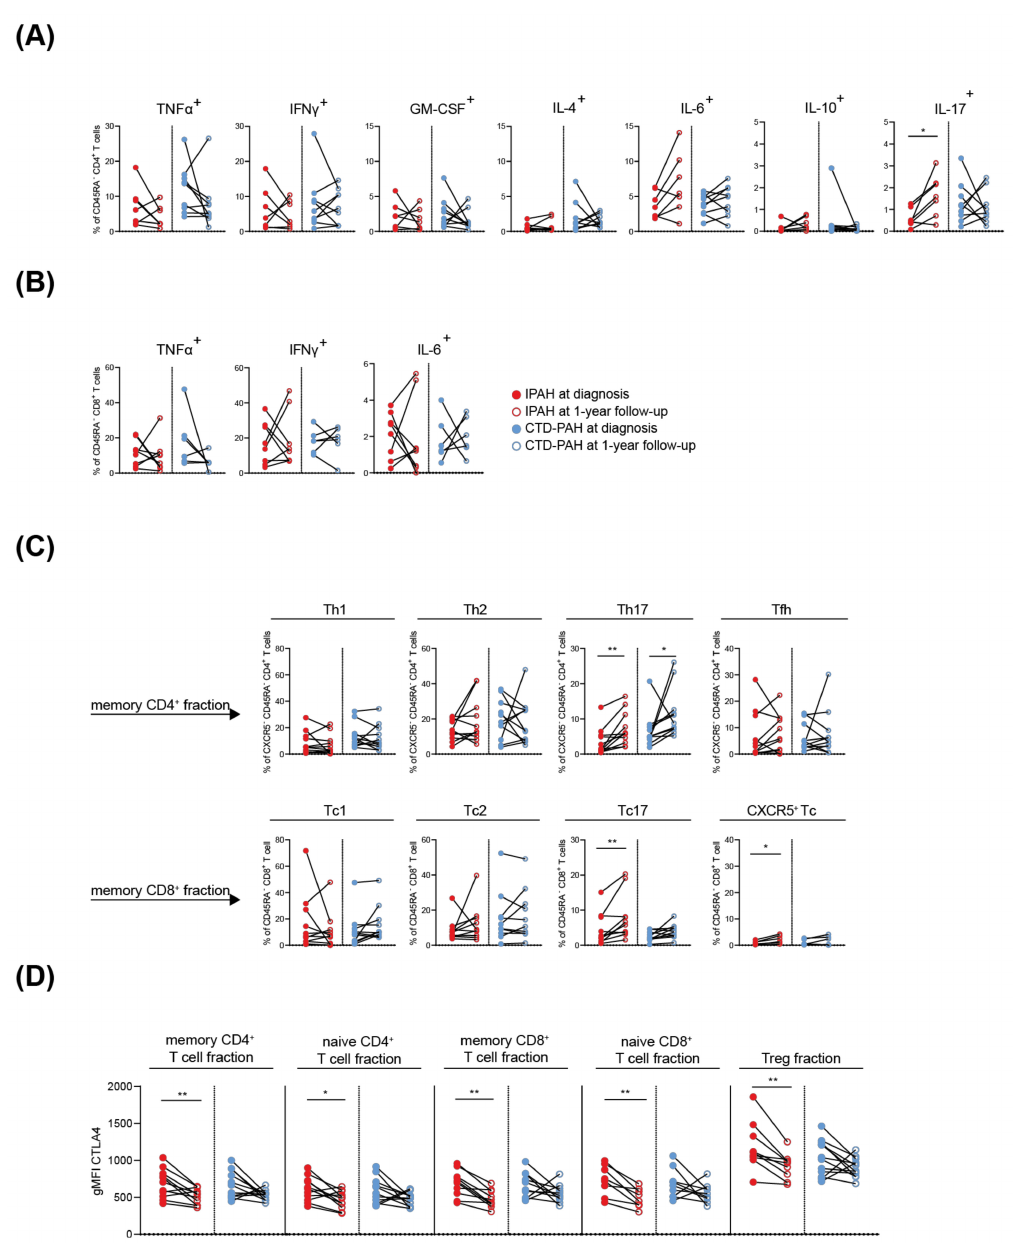
Figure 4. T cell profile changes over time in PAH patients. ( A , B ) Quantification of the proportions of CD45RA − CD4 + memory T cells ( A ) and CD45RA − CD8 + memory T cells ( B ) producing the indicated cytokines in paired samples from IPAH and CTD-PAH patients at diagnosis and at 1-year follow-up. ( C ) Proportions of peripheral blood CD4 + and CD8 + T cell subsets, based on chemokine receptor expression, in paired samples from PAH patients at diagnosis and 1-year follow-up. ( D ) Quantification of CTLA4 expression in the indicated T cell fractions in samples from IPAH and CTD-PAH patients at diagnosis and 1-year follow-up. Closed and open circles represent values of individual patients at diagnosis and 1-year follow-up, respectively. Paired samples are connected by a line. Wilcoxon matched-pairs signed-rank test was used for statistical analysis, * p < 0.05, ** p < 0.01. gMFI = geometric mean fluorescence